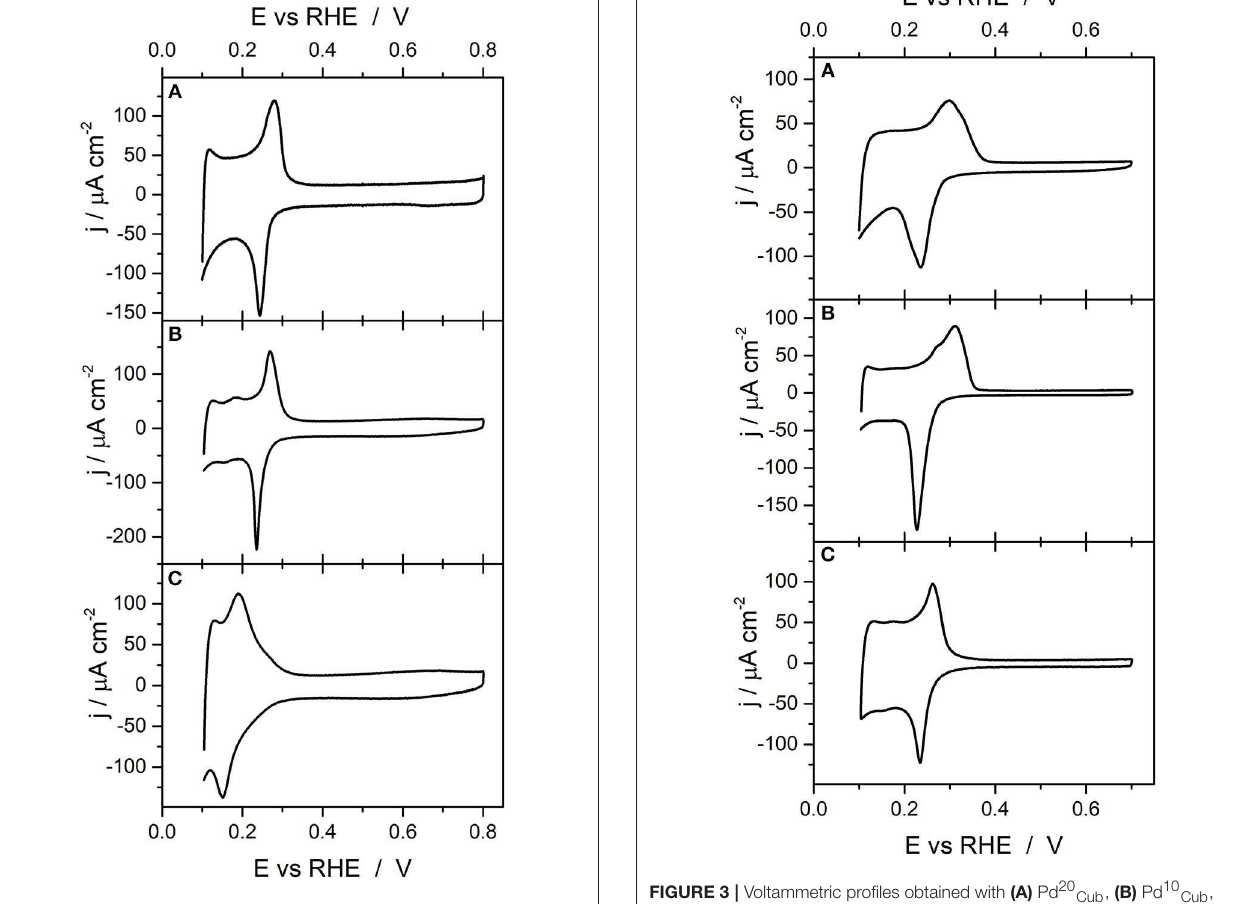
FIGURE 2 | Voltammetric profiles obtained with (A) Pd Cub , (B) Pd Oct , and (C) Pd RD nanoparticles. Test solution 0.1M H 2 SO 4 , scan rate 50mV s − 1 .